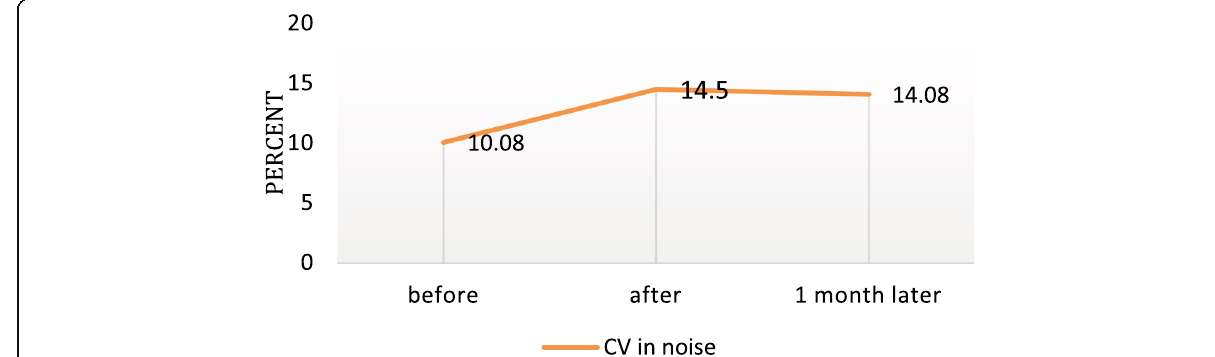
Fig. 4 The results of the repeated measures test showed that the mean score of “ CV in noise ” had a statistically significant difference in three measurements ( P .value < 0.05). The Tukey test showed that there was a statistically significant difference between the first score and the second score ( P .value < 0.05), while there is no statistically significant difference between the second score and the third score ( P .value < 0.05)